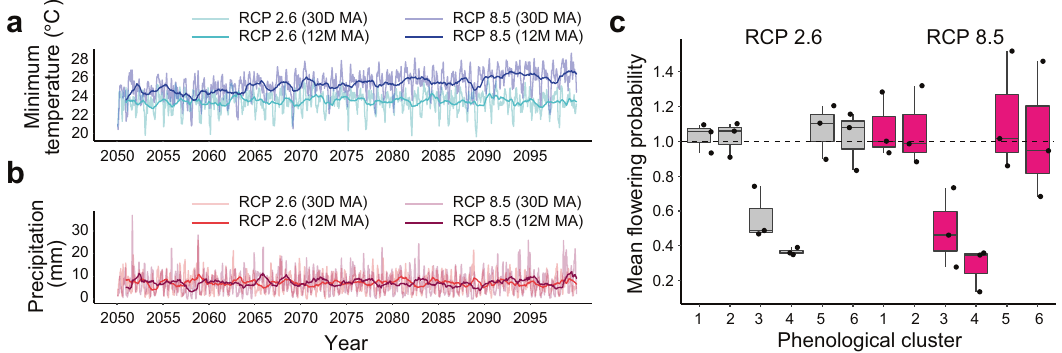
Fig. 5 Prediction of future fl owering phenology under two climate scenarios (RCP2.6 and RCP8.5). Minimum temperature ( a ) and precipitation ( b ) simulated by GDFL – EMS2M for 2050 – 2099. The 30-day (30 D) and 12-month (12 M) moving averages (MAs) were plotted. c Box plots of normalized fl owering probabilities predicted for 2050 – 2099 for each phenological cluster under two climate scenarios. Predictions from three GCMs (GDFL – EMS2M, IPSL – CM5A-LR, and MIROC5) were plotted as points. For each model, the prediction was normalized using the 1976 – 1996 phenology of each phenological cluster. A dotted line indicates the level that is equal to the one for the 1976 – 1996 period. The horizontal line inside each box and the length of each box indicate the median and the interquartile range (the range between the 25th and 75th percentiles), respectively. The whiskers indicate points within 1.5 times the interquartile